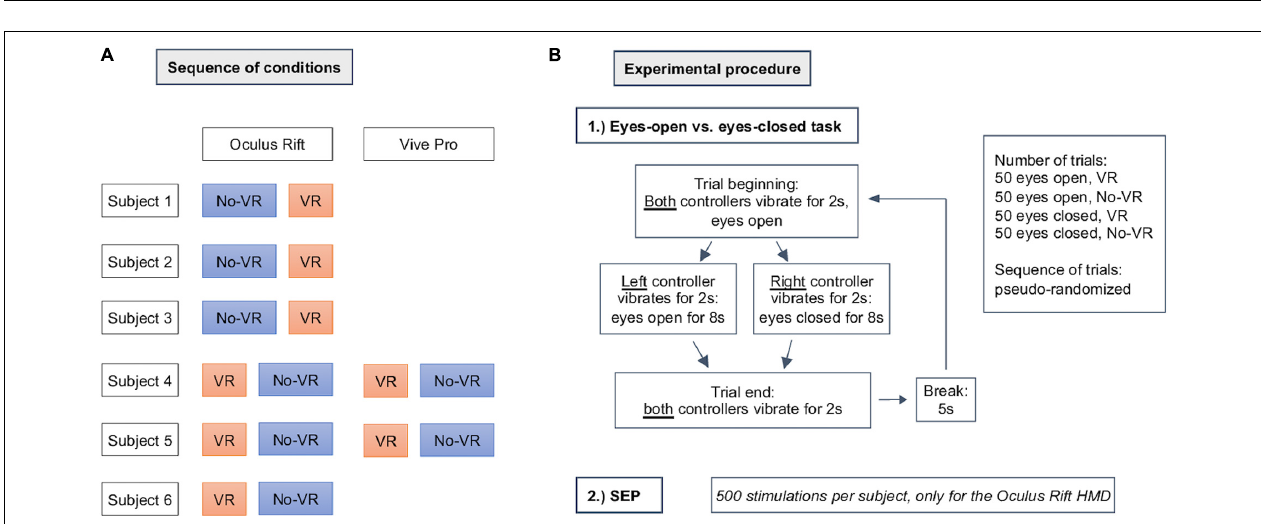
FIGURE 1 | Experimental environment for VR (A) and No-VR (B) conditions. (A) Shows a virtual copy of the real-world-template (B) where the experiment was conducted. (A) Shows a screenshot of the presented environment in the HMD. Wall color, texture, floor, ceiling light, room brightness and fixation cross were comparable. The position of the subject in the experimental environment was identical.